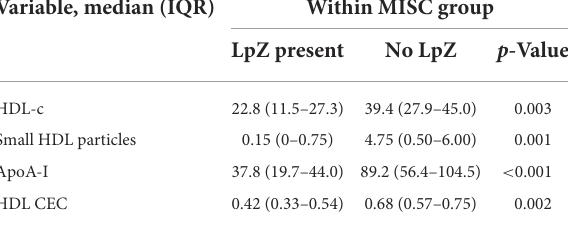
TABLE 4 LpZ in MISC associates with lower HDL parameters and function. Variable, median (IQR)